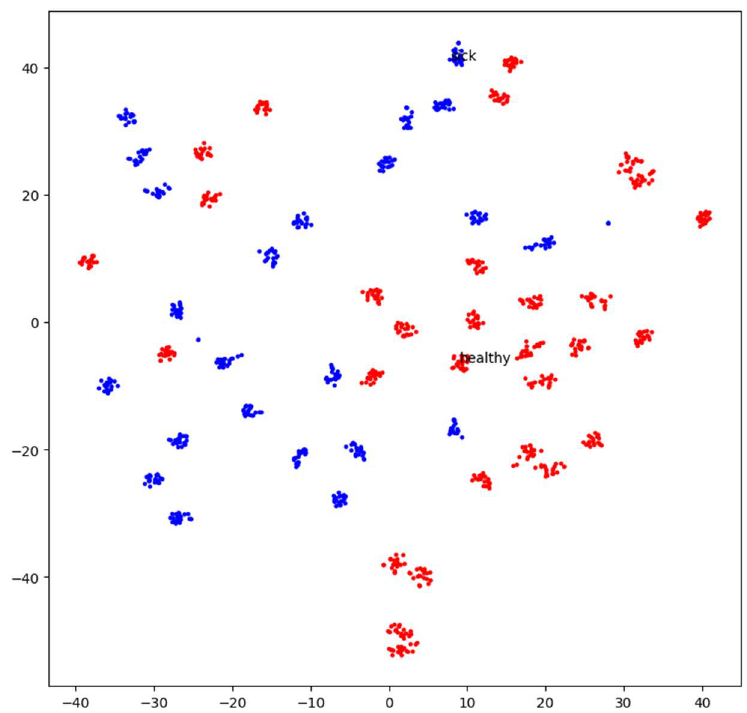
Figure 13. The spatial distribution of our (retrained InceptionV3) model extracted feature representation shows how well features are grouped. In Red, we see elements classified as Healthy (For Healthy Breast), and In Blue, we see features organized as Sick (For Sick Breast or Breast with Cancer).